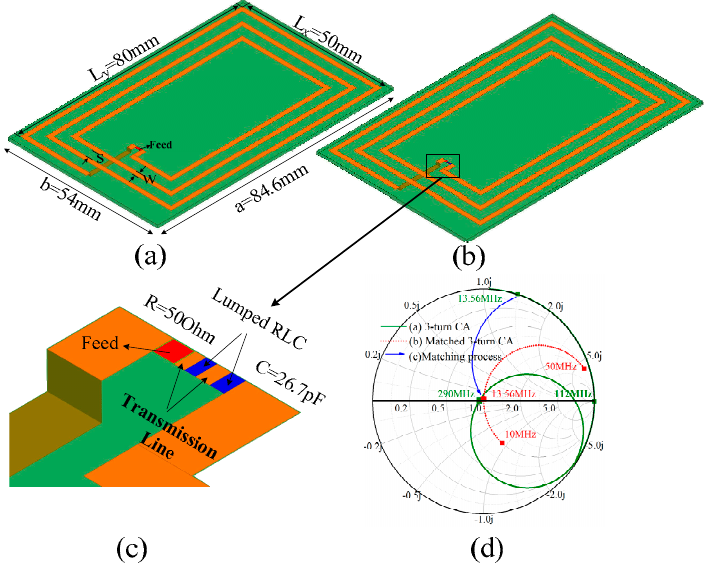
Figure 1. A simple 3-turn CA ( a ) without matching circuit, ( b ) with an obsolete matching circuit ( c ); zoom-in of the schematic of matching circuit in simulation; ( d ) their s-parameters on Smith chart. From its performance on the Smith chart in Figure 1d, the red dotted line and green solid line represent the S-parameter of a three-turn CA with and without a matching circuit, respectively. Simultaneously, the blue arrow line denotes the matching process of the desired frequency from the red dotted line to the green solid line at 13.56